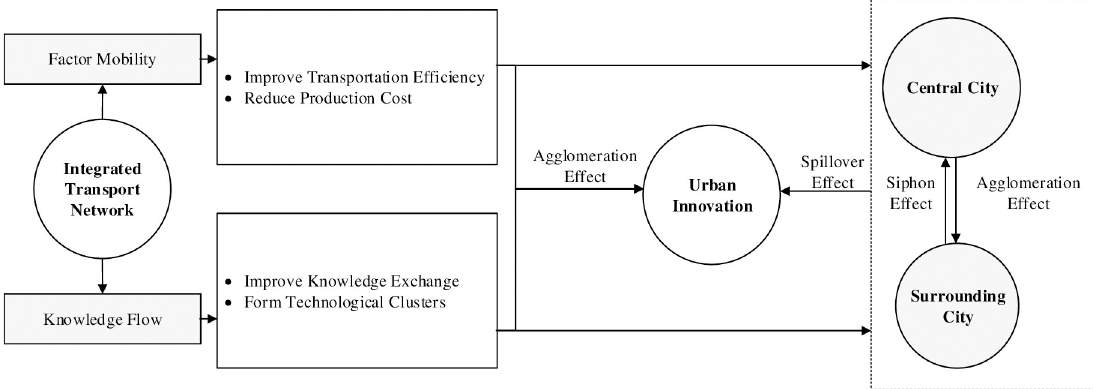
Fig 1. Conceptual framework of integrated transport network influencing urban